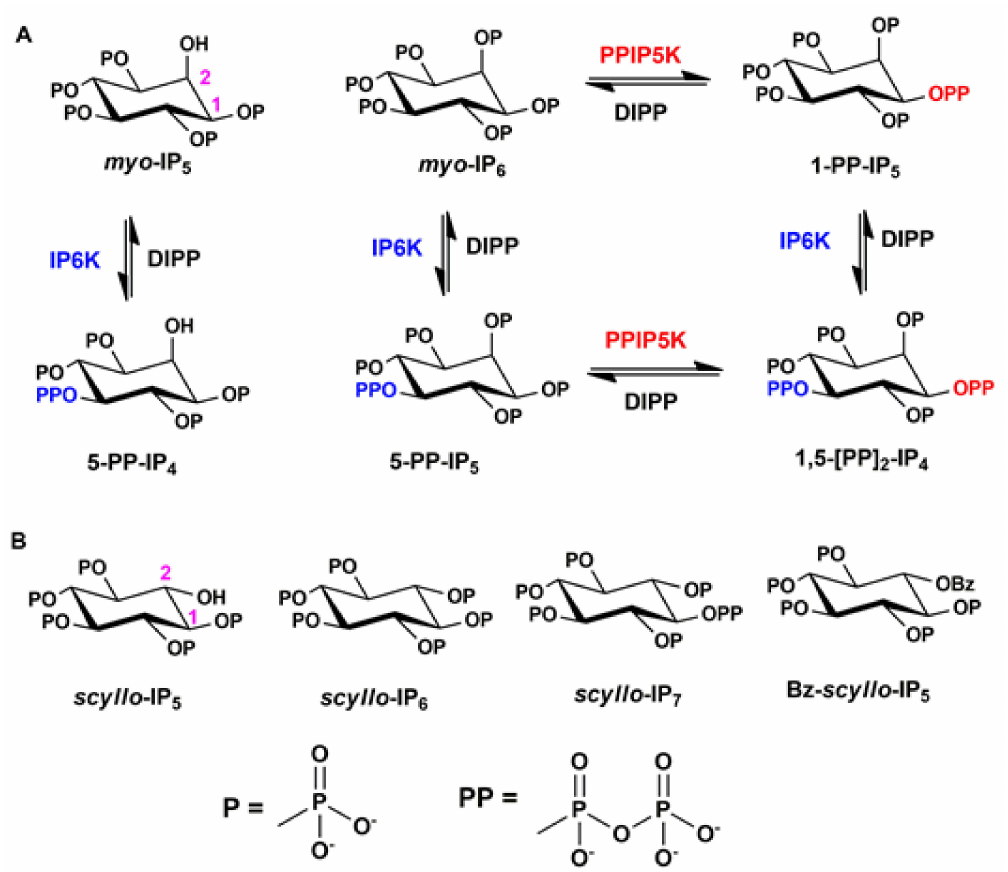
Figure 1. ( A ) Biosynthesis of inositol pyrophosphates in mammalian cells. ( B ) Proposed ligands to probe kinase